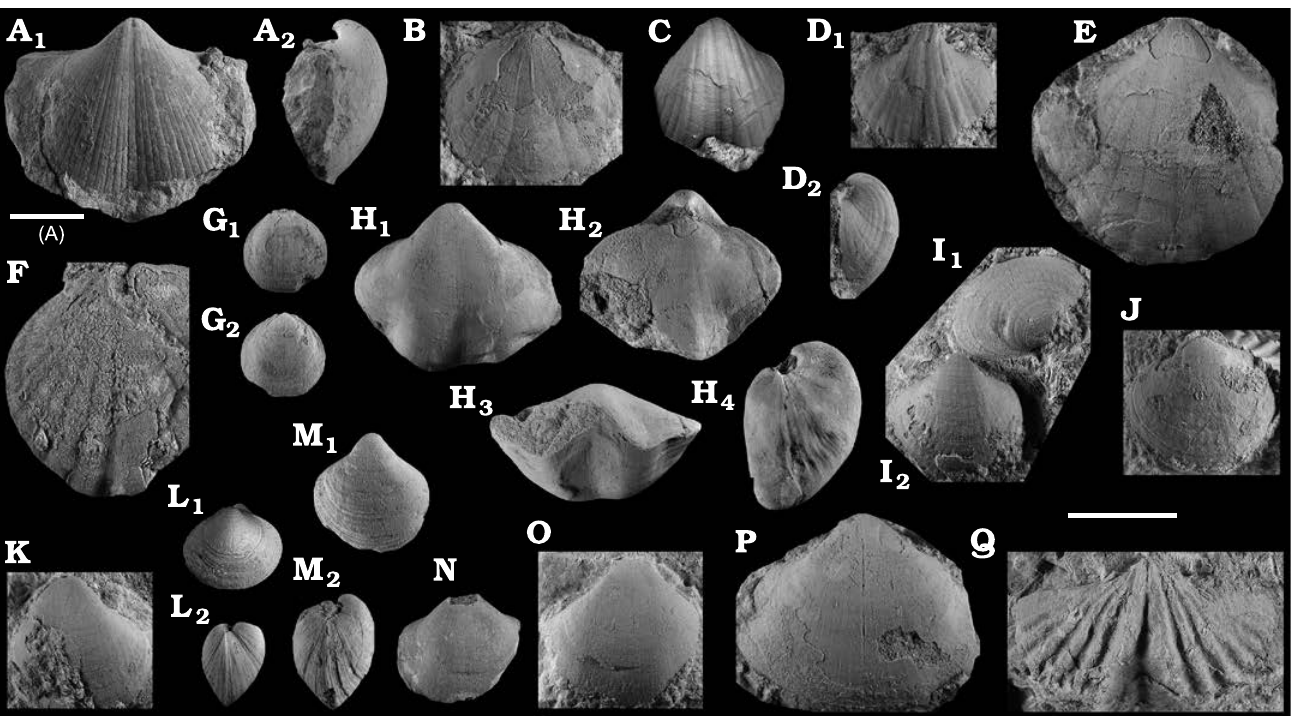
Fig. 16. Spiriferida and Spiriferinida from the Brigantian (uppermost Visean) of Ricklow Quarry, near Monyash (localities RCC-, RCK-; Fig. 3) and Wensley Dale, near Matlock (locality WI1; Fig. 2), Derbyshire, UK. A . Latibrachythyris cf. crassa (De Koninck, 1843), MPUM12040 (RCC54- 10a) ventral valve in ventral (A 1 ) and lateral (A 2 ) views. B – D . Latibrachythyris rotundata (Sowerby, 1825). B . MPUM12047 (RCC65G-12) dorsal valve in dorsal view. C . MPUM12043 (RCK15-1a) in ventral view. D . MPUM12045 (RCK15-40) ventral valve in ventral (D 1 ) and lateral (D 2 ) views. E , F . Brachythyrididae gen. et sp. indet. E . MPUM12049 (RCC11-8) ventral valve in ventral view. F . MPUM12052 (RCC42-5a) dorsal valve in dorsal view. G . Reticularia cf. mesoloba (Phillips, 1836), MPUM12053 (RCK15-43) in ventral (G 1 ) and dorsal (G 2 ) views. H . Georgethyris lobata (Muir- Wood, 1926), MPUM12086 (WI1-9) in ventral (H 1 ), dorsal (H 2 ), anterior (H 3 ) and lateral (H 4 ) views. I – K . Phricodothyris paricosta George, 1932. I . MPUM12058 (RCK15-34a) dorsal valve (I 1 ) and MPUM12055 (RCK15-34b) ventral valve (I 2 ). J . MPUM12057 (RCK15-9) dorsal valve in dorsal view. K . MPUM12054 (RCC40-10a) ventral valve in ventral view. L – N . Phricodothyris cf. periculosa George, 1932. L . MPUM12061 (RCK15-3) in dorsal (L 1 ) and lateral (L 2 ) views. M . MPUM12060 (RCC73-30a) in ventral (M 1 ) and lateral (M 2 ) views. N . MPUM12064 (RCC2-37) ventral valve in ventral view. O . Phricodothyris sp., MPUM12071 (RCC60-4a) ventral valve in ventral view. P . Nebenothyris sp., MPUM12073 (WI1-26a) ventral valve in ventral view. Q . ? Punctospirifer sp., MPUM12074 (RCC73-23c) ventral valve in ventral view. Scale bars 10